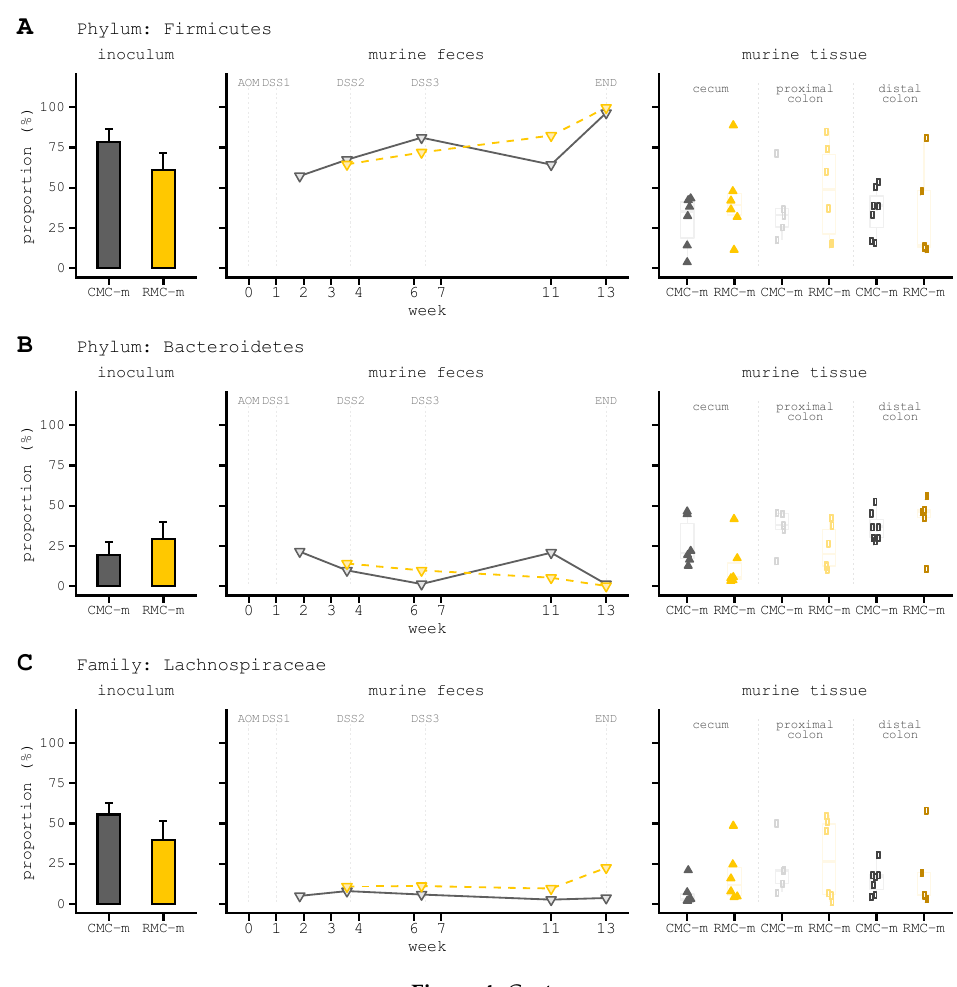
Figure 4. Taxonomic composition (proportions) of human male donor stool inoculums into murine feces, cecum, and colon. ( A ) Firmicutes proportions for stool inoculums and samples from mice colonized with consortia derived from the human male. ( B ) Bacteroidetes ( C ) Lachnospiraceae ( D ) Bifidobacterium ( E ) Lactobacillus ( A – E ) the y ‐ axis is identical across plots within a given panel and is set at 100% for all panels depicted. Taxonomy was collapsed at the phylum ( A , B ) family ( C ) or genus ‐ ( D , E ) levels to combine proportions for identical assignments prior to visualization. Taxonomy was assigned using the SILVA 132 marker gene database.